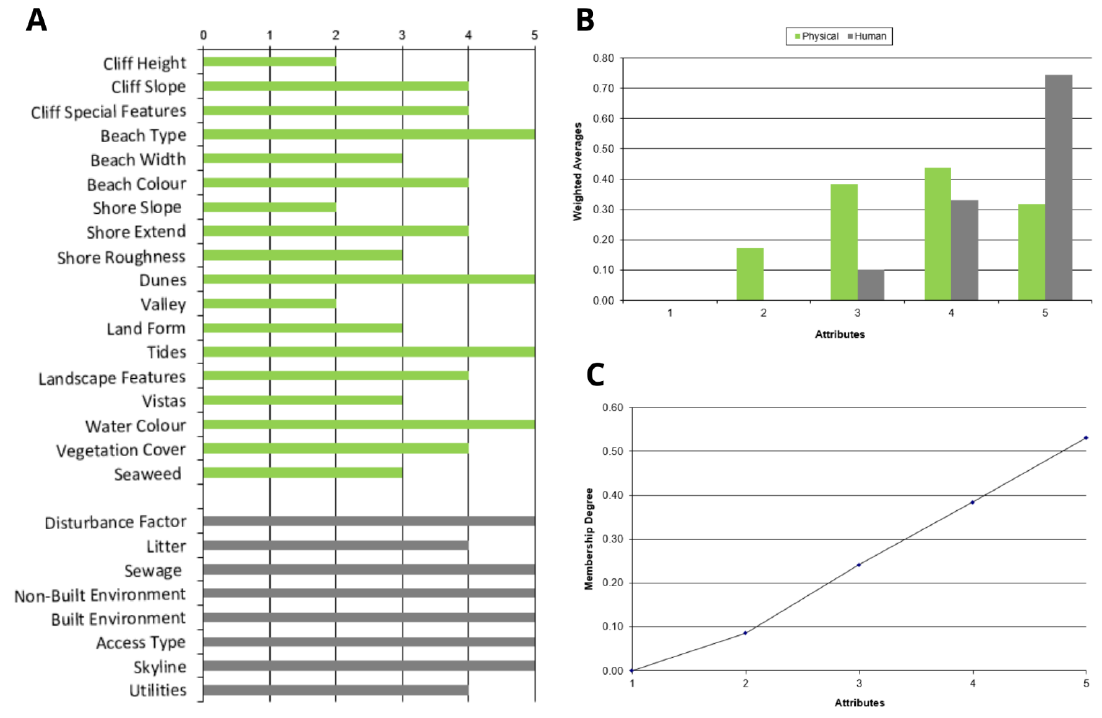
Figure 4. CSES parameters ratings for Mongofra, Menorca (D: 1.00; class I) ( A ), weighted averages vs. attributes ( B ) and membership degree vs. attributes ( C ).